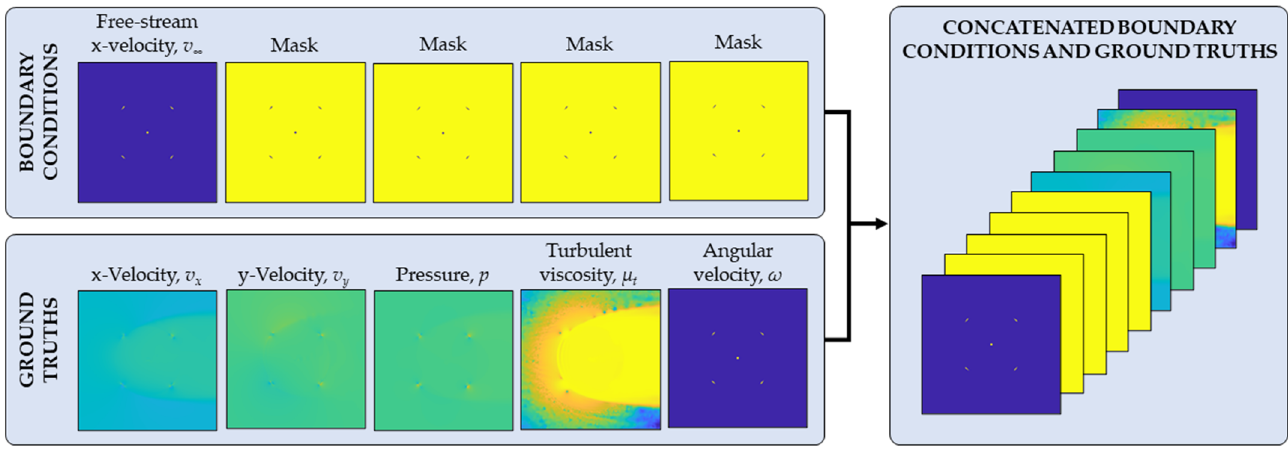
Figure 4. Boundary conditions and ground